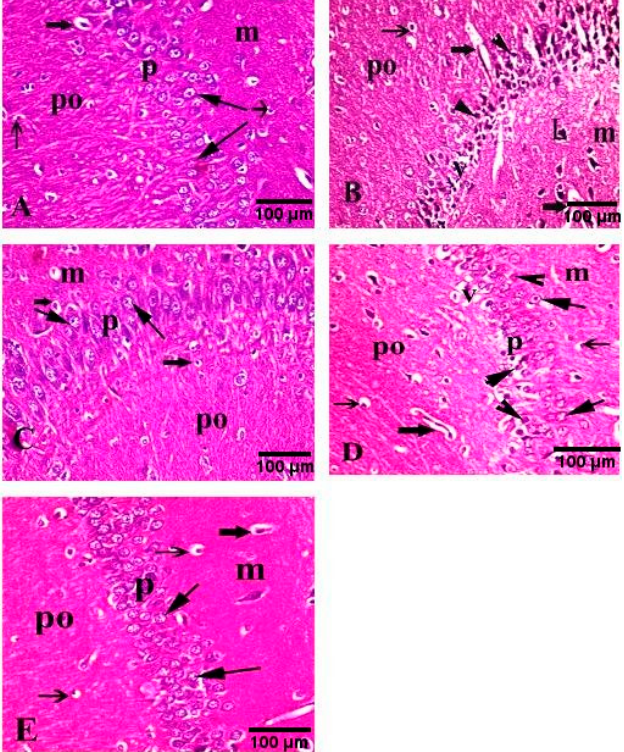
Figure 6. Photomicrographs of the hippocampal Cornu Ammonis region of rats (H&E, 400 × ). ( A ) Control rats revealed a normal appearance of molecular (m), pyramidal (p) and polymorphic layers (po). ( B ) AlCl 3 -treated animals revealed loss of normal structure. Distorted pyramidal layers reveal marked shrinkage and degenerative changes in pyramidal cells with pyknotic nuclei (arrow- head) and empty areas of pyramidal cell loss (v). Severe dilation of blood capillaries (thick arrow), enlargement of neurons (L) and glial cells (thin arrow) were noticed in molecular (m) and poly- morphic layers (po). ( C ) AlCl 3 -rivastigmine-treated animals revealed normal histological structure of molecular (m), pyramidal (p) and polymorphic layers (po) with a mild reduction in pyramidal cells (arrow) of the pyramidal layer (p) and moderately dilated blood capillaries (thick arrow). ( D ) AlCl 3 /low dose of the extract-treated animals revealed some pyramidal neurons with normal structure, vesicular nuclei (arrow) and other neurons with moderate degenerative changes and pyknotic nuclei (head arrow) accompanied by loss of some cells (v). Mildly dilated blood capillaries (thick arrow) in polymorphic layer (po) and normal glial cells (thin arrow) in molecular layers (m) and polymorphic layer (po) were seen. ( E ) AlCl 3 /high dose of the extract-treated animals revealed normal appearance of molecular (m), pyramidal (m) and polymorphic layers (po). The pyramidal layer (p) showed reappearance of normal pyramidal cells with vesicular nuclei